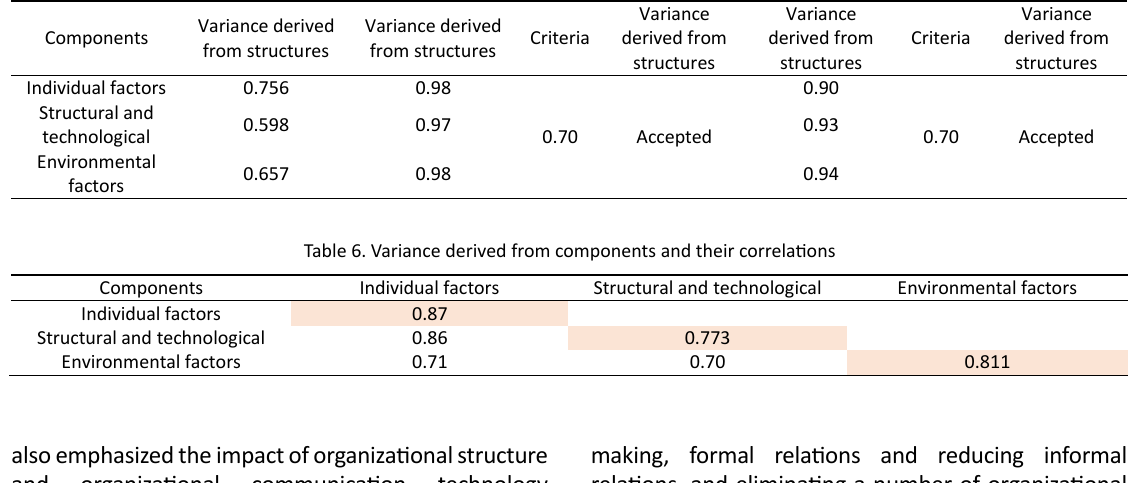
Table 5. Variance derived from components and their reliability